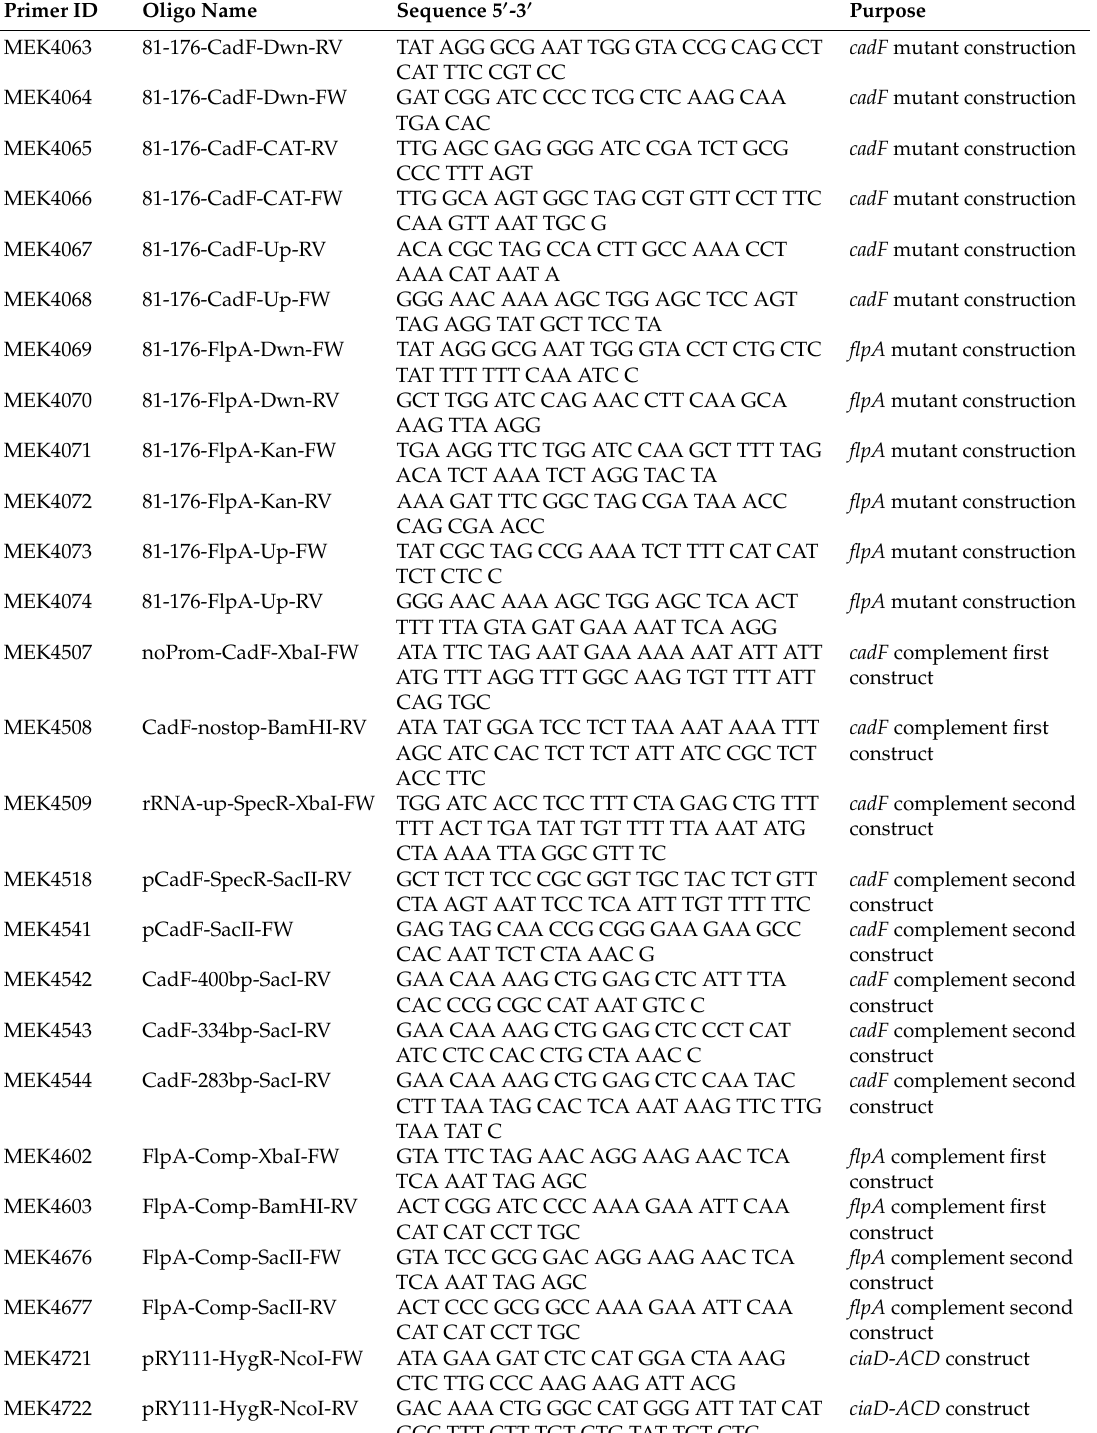
Table 3. Primers used in this